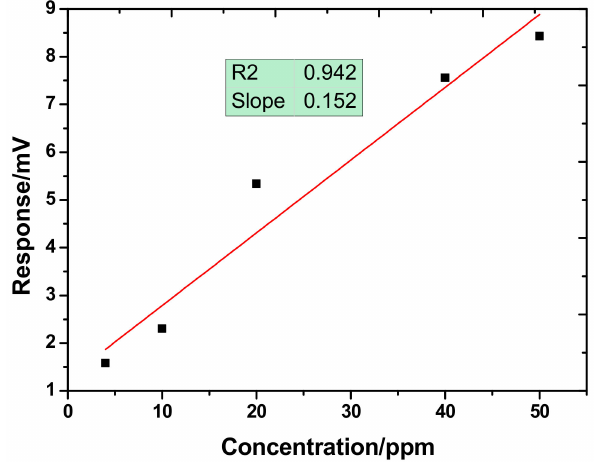
Figure 8. Responses of SAW sensor to different concentrations of H 2 S.